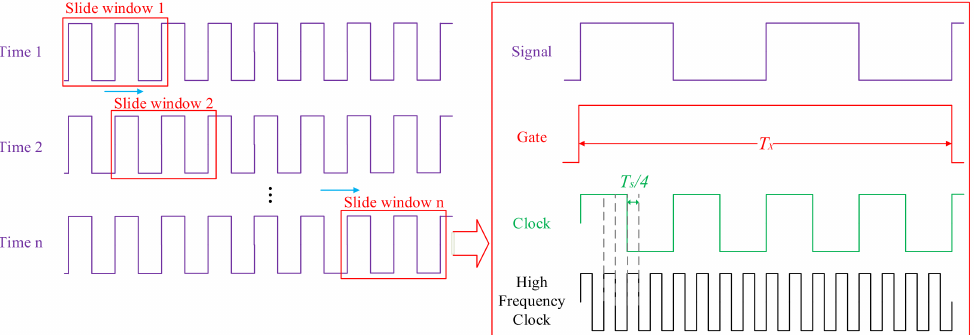
Figure 9. Frequency doubling and sliding window filter